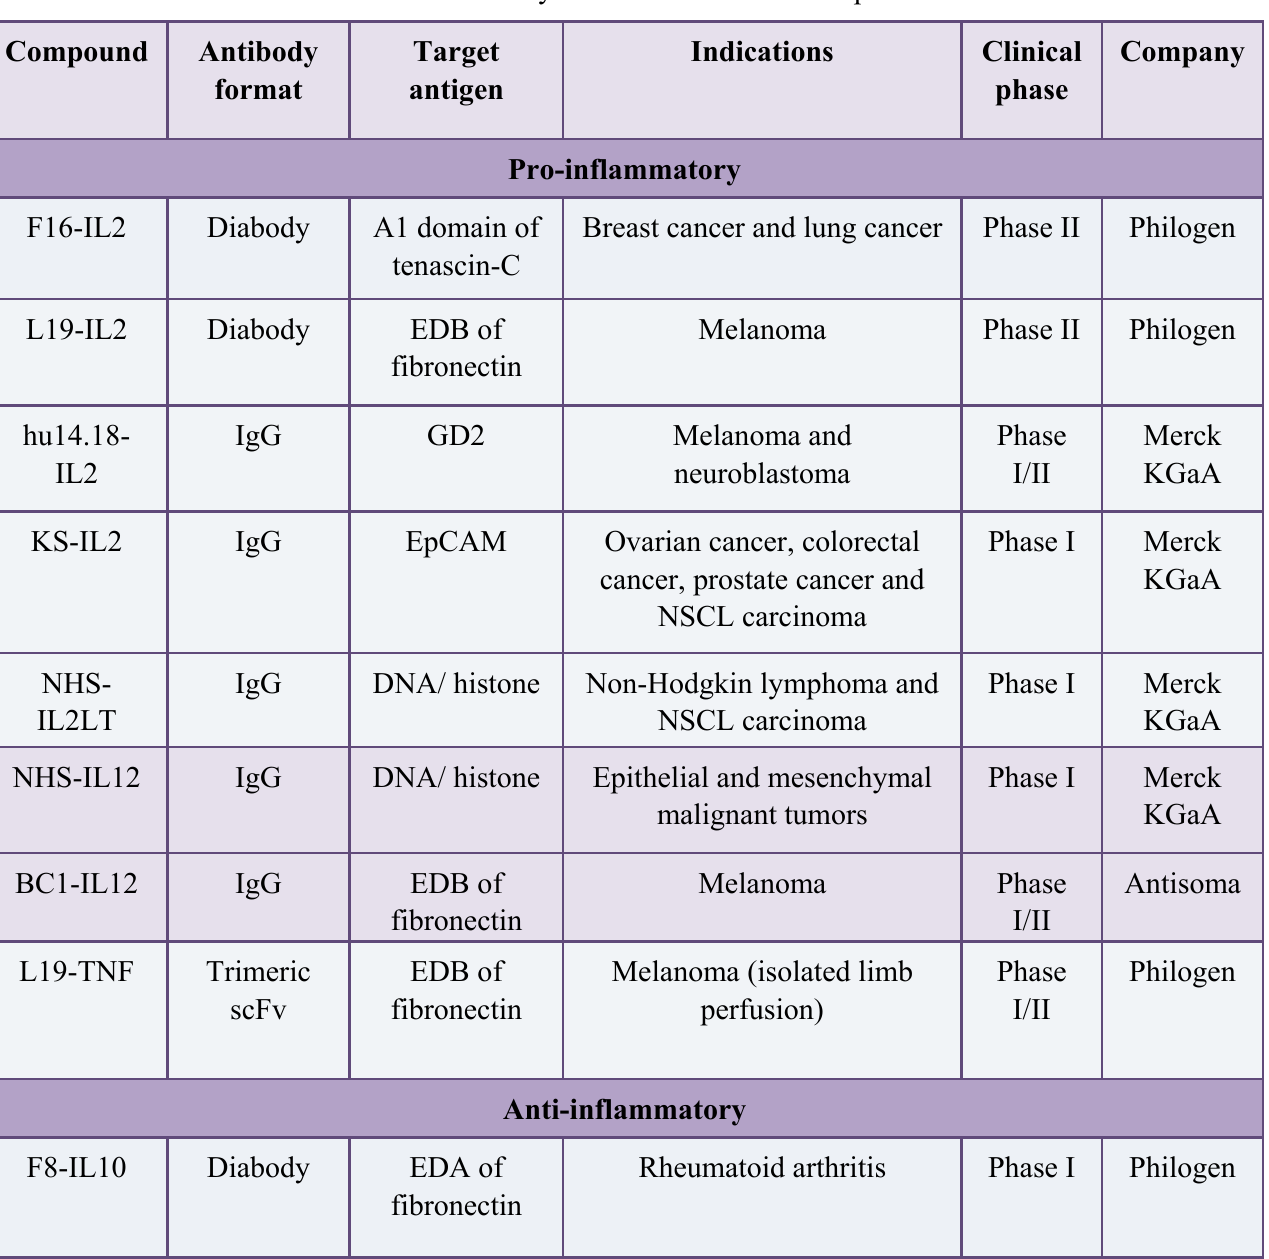
Table 2. Immunocytokines in clinical